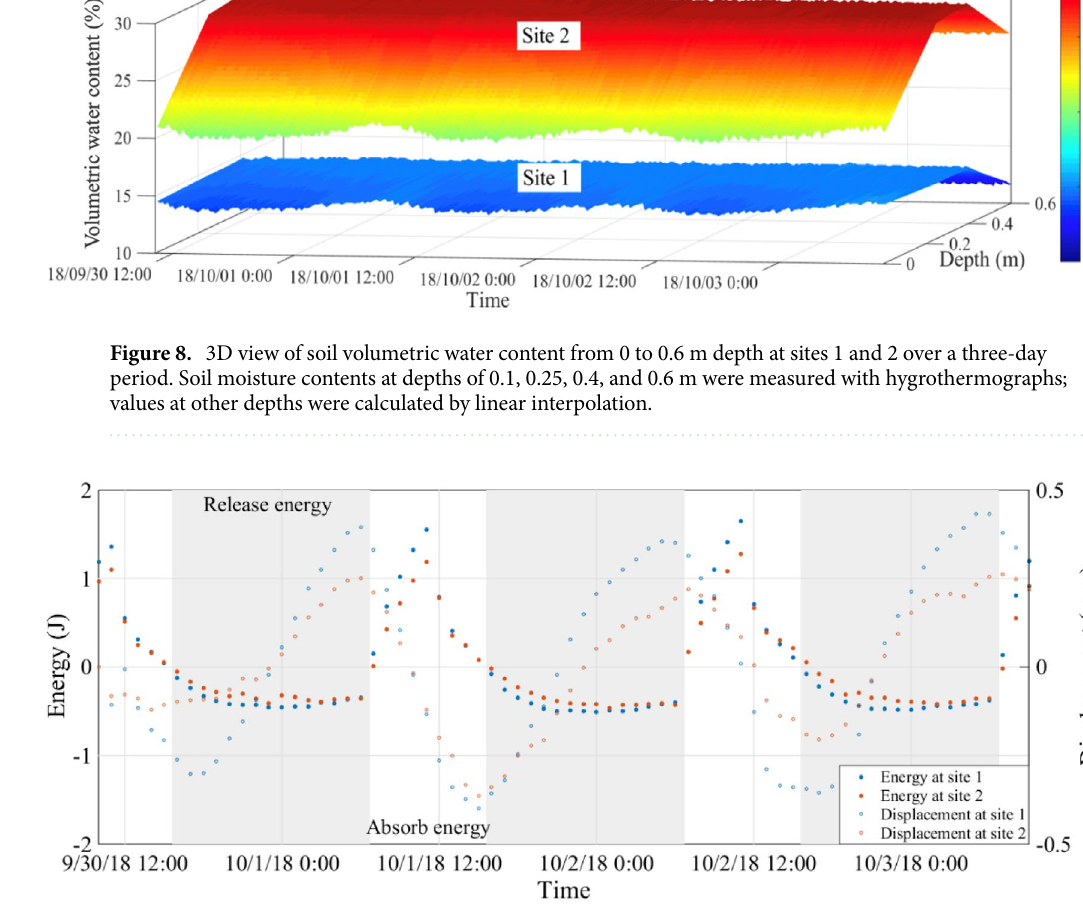
Figure 9. Energy fluctuation at the two sites during a three-day interval, estimated from soil temperature and moisture data. Positive values indicate energy absorption (white background), and negative values indicate energy release (gray